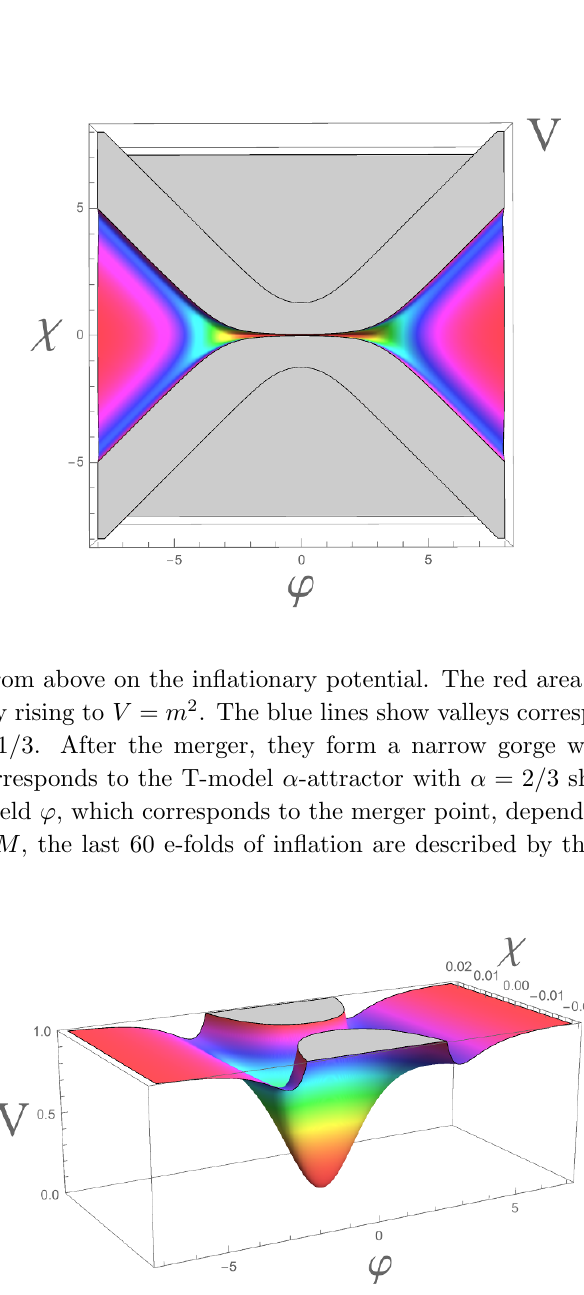
Figure 12 . A part of the (cid:12)gure 11 shown in the same range of ’ as in (cid:12)gure 11, but in a very narrow range of (cid:31) near the in(cid:13)aton direction (cid:31) = 0. One can easily recognize the T-model potential V = m 2 tanh 2 ’ with 3 (cid:11) = 2, which is produced by merging of the in(cid:13)aton directions with 3 (cid:11) = 1 2 shown by the blue lines in the (cid:12)gure